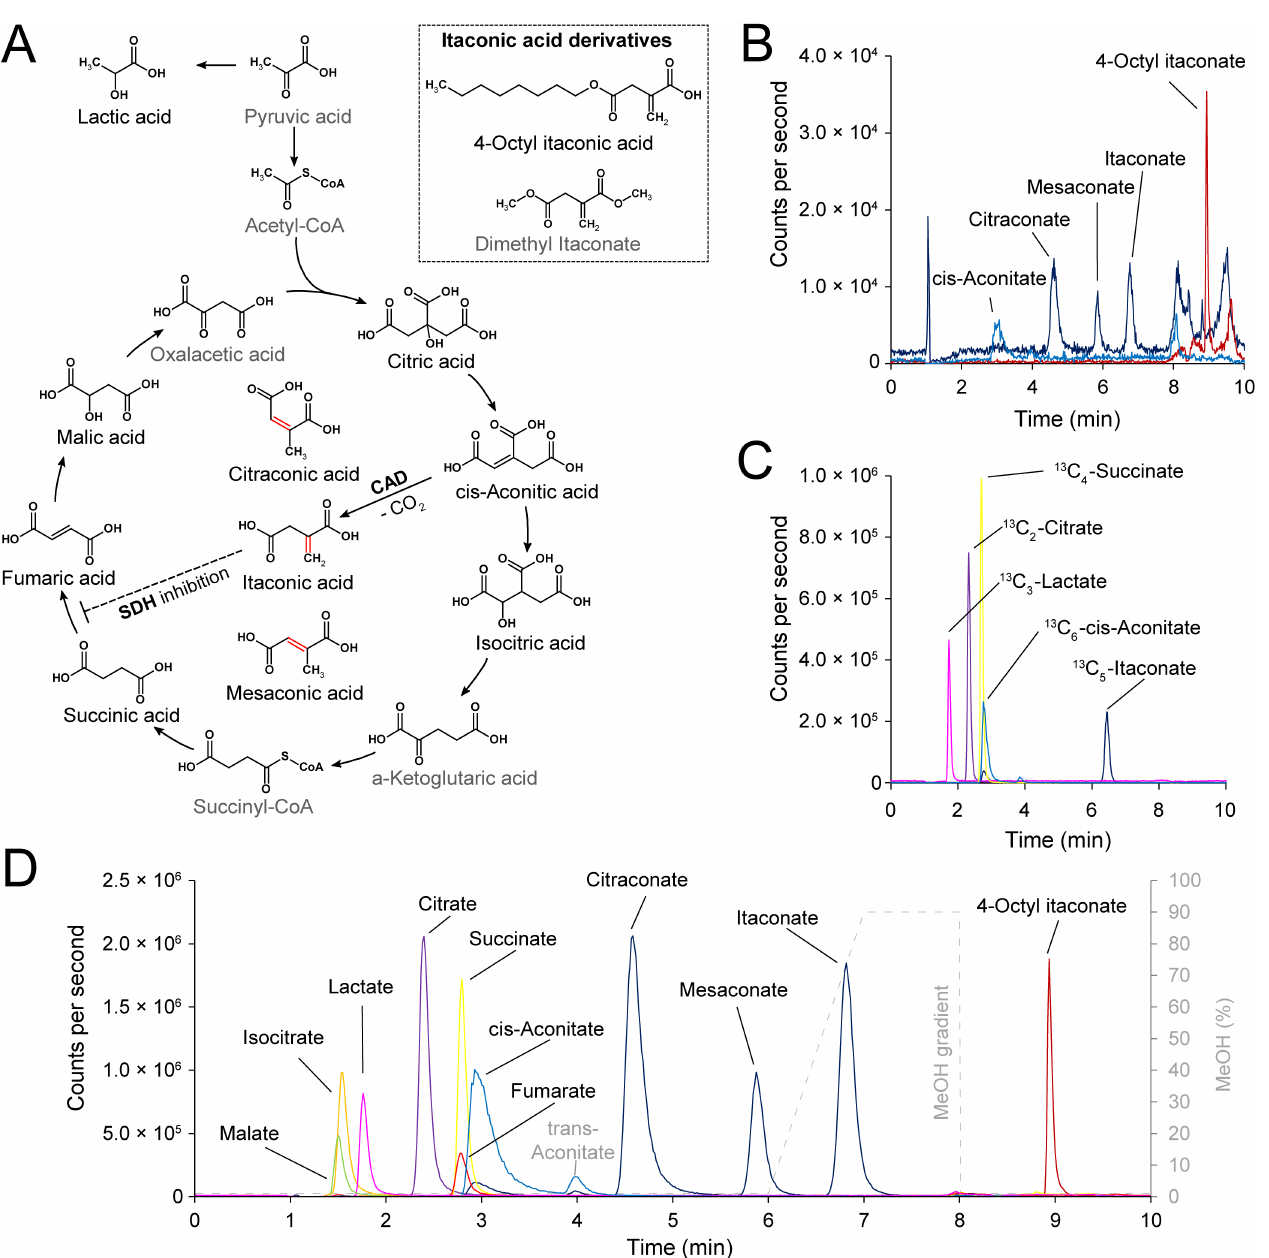
Figure 1. Detection of itaconate and isomers by high performance liquid chromatography-tandem mass spectrometry (HPLC-MS/MS). ( A )—Chemical structures of tricarboxylic acid (TCA) cycle intermediates, itaconic acid isomers and derivatives. Compounds that can be quantified by the HPLC-MS/MS assay are highlighted in black. ( B )—HPLC-MS/MS ion chromatogram of cis- aconitate, itaconic acid and isomers, and 4-octyl itaconate at the lower limit of quantification (LLOQ) (245 fmol on column for cis- aconitate and citraconate; 490 fmol on column for itaconate and mesaconate and 100 fmol on column for 4-octyl-itaconate). ( C )—HPLC-MS/MS ion chromatograms of the employed internal standards. ( D )—HPLC-MS/MS ion chromatograms of all analytes included in the method are highlighted in black. 4-octyl-itaconate eluted after applying the methanol gradient (dashed line in grey); trans -aconitate (grey) could be identified but was not quantified in this assay.